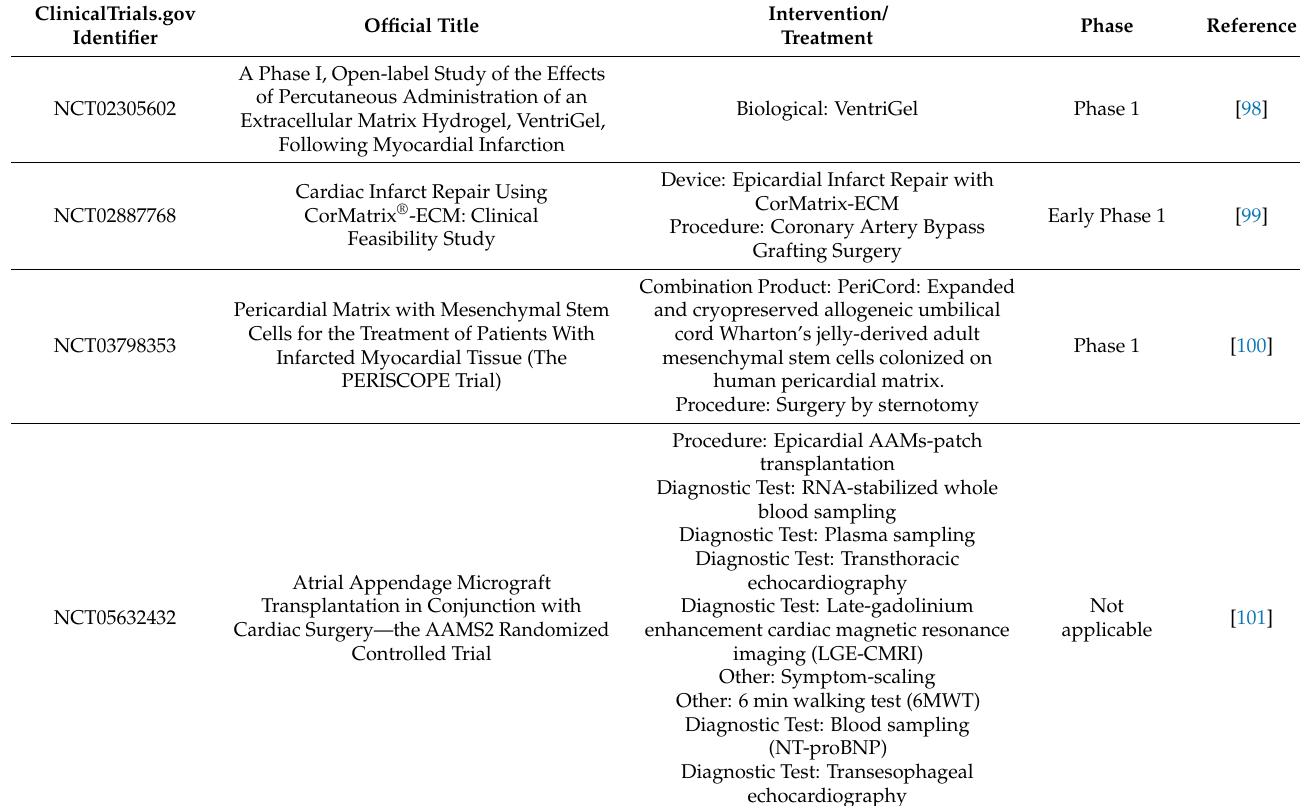
Table 2. Clinical trials involving biomaterials for cardiac tissue engineering and